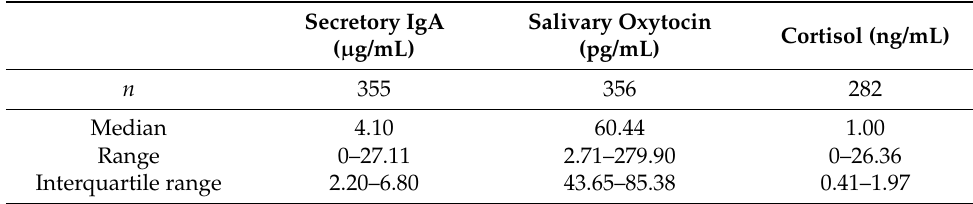
Table 2. Summary of descriptive statistics for secretory IgA, salivary oxytocin, and serum cortisol in bull Asian elephants during socialization of two all-male groups.